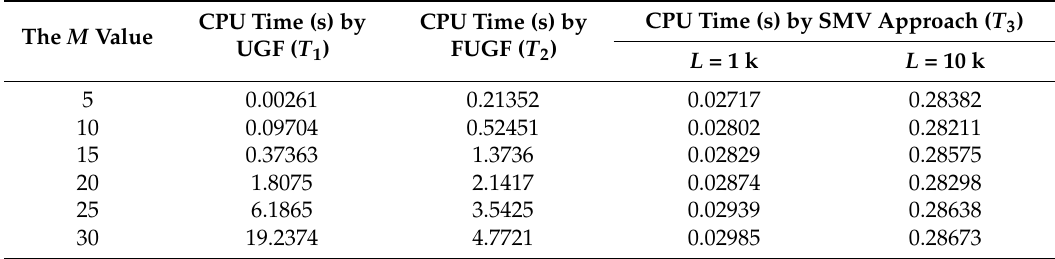
Table 4. Efficiency comparison for a system of model II with six components.